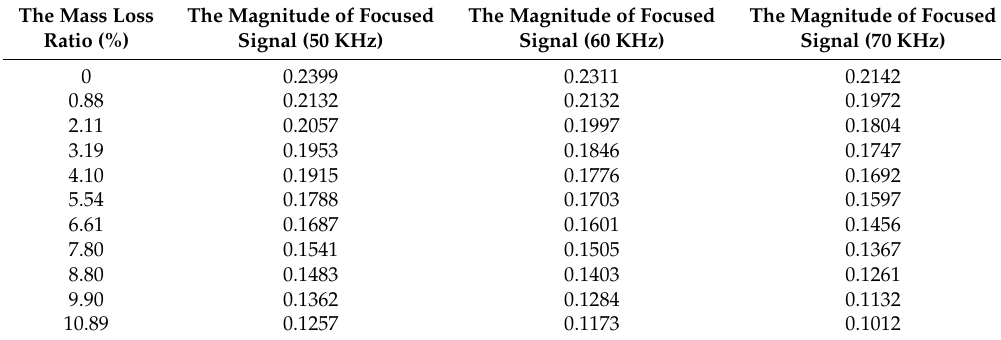
Table 1. The data of specimen no. 1.